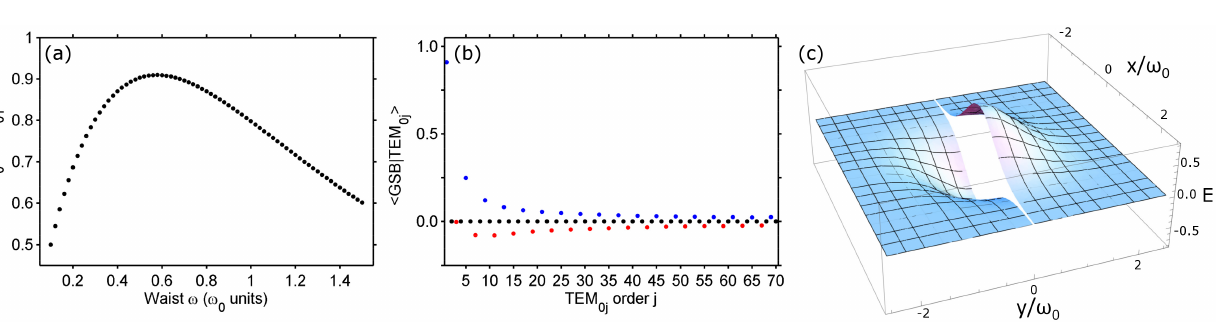
mode with waist ω 00 0 . 0 basis. 0 i mode 0 i (blue dots) and TEM 04 j +1 04 j +3